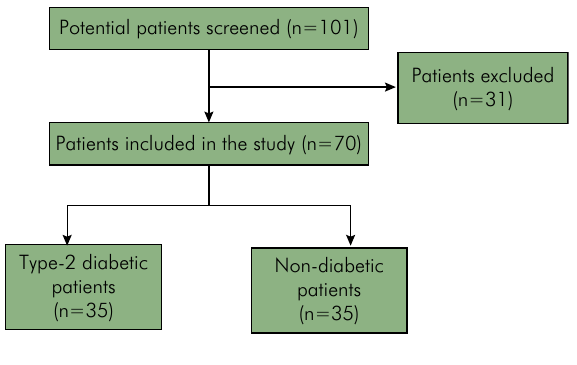
Figure. Study flow diagram showing recruitment details.